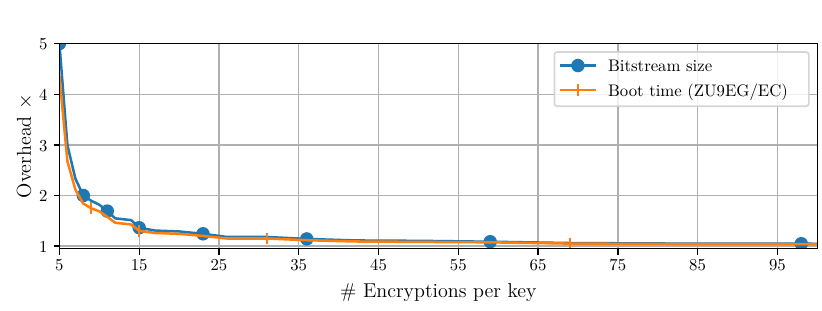
Figure 10: Normalized bitstream size and boot time for different key rolling values. The numbers have been calculated using the scripts provided at [ZU